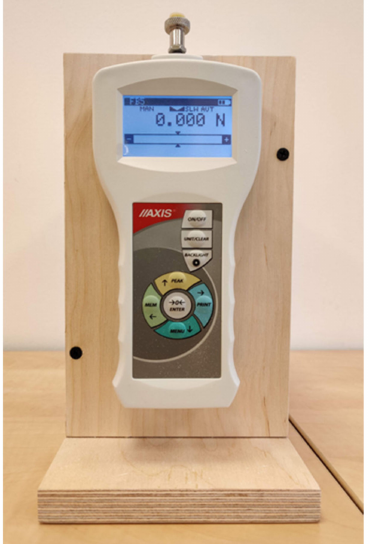
Figure 1. Force sensor used in the